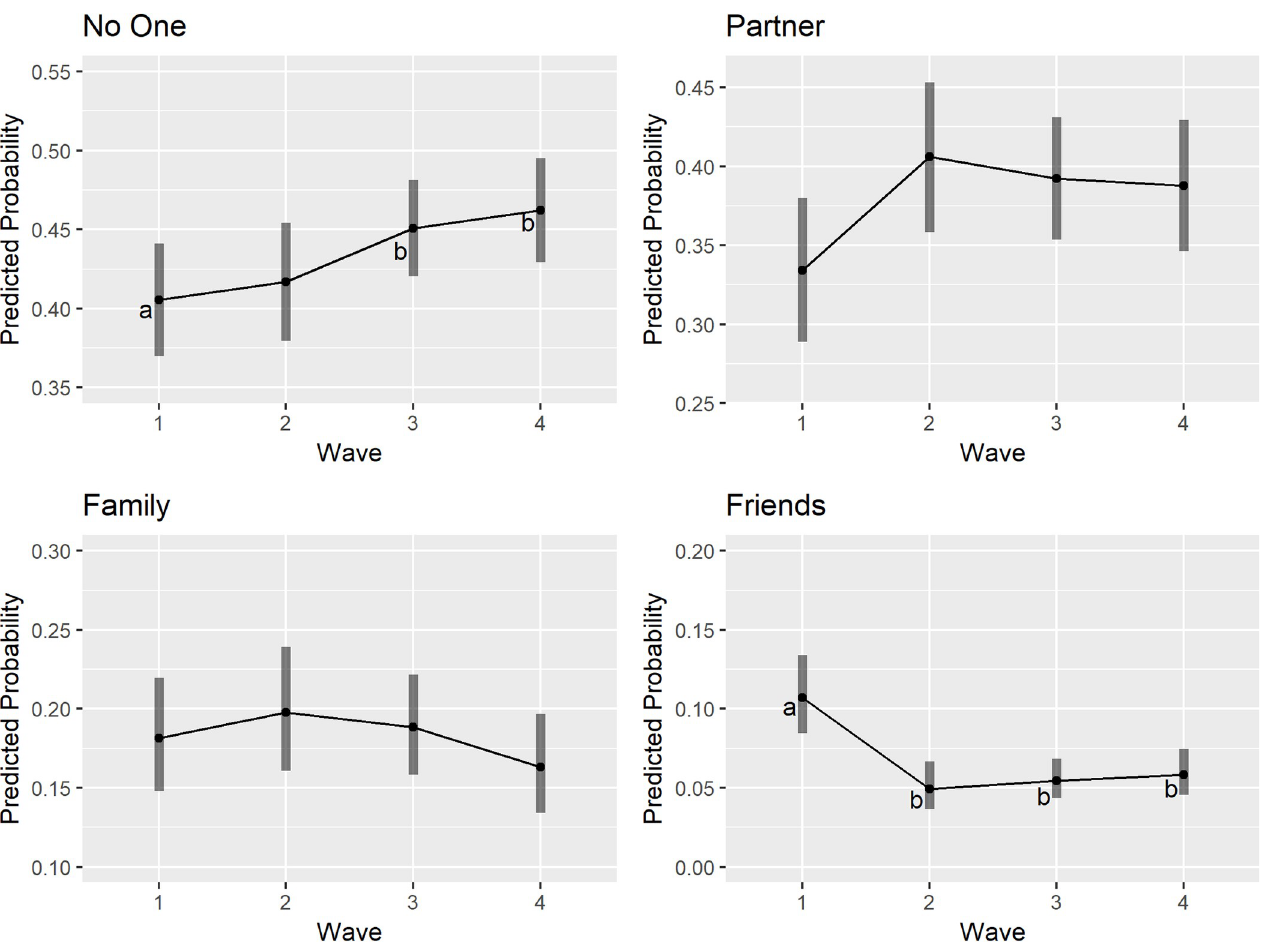
Fig 1. The predicted probabilities of various momentary social interactions across waves. Note . For models with a significant overall effect of wave, different letters indicate that the predicted probabilities in those waves were significantly different from each other. across waves. The same model was conducted for NA. Results showed that the overall effect of wave on NA was significant ( F (3, 309.76) = 4.50, p = .004) and follow-up contrasts indicated that NA means at Wave 3 (mean = 13.60; z = -2.48, SE = 0.83, p = .015) and Wave 4 (mean = 13.14; z = -2.94, SE = 0.88, p = .004) were significantly lower than NA at Wave 2 (mean = 16.08). The predicted means of momentary affect across waves are shown in Fig 2.